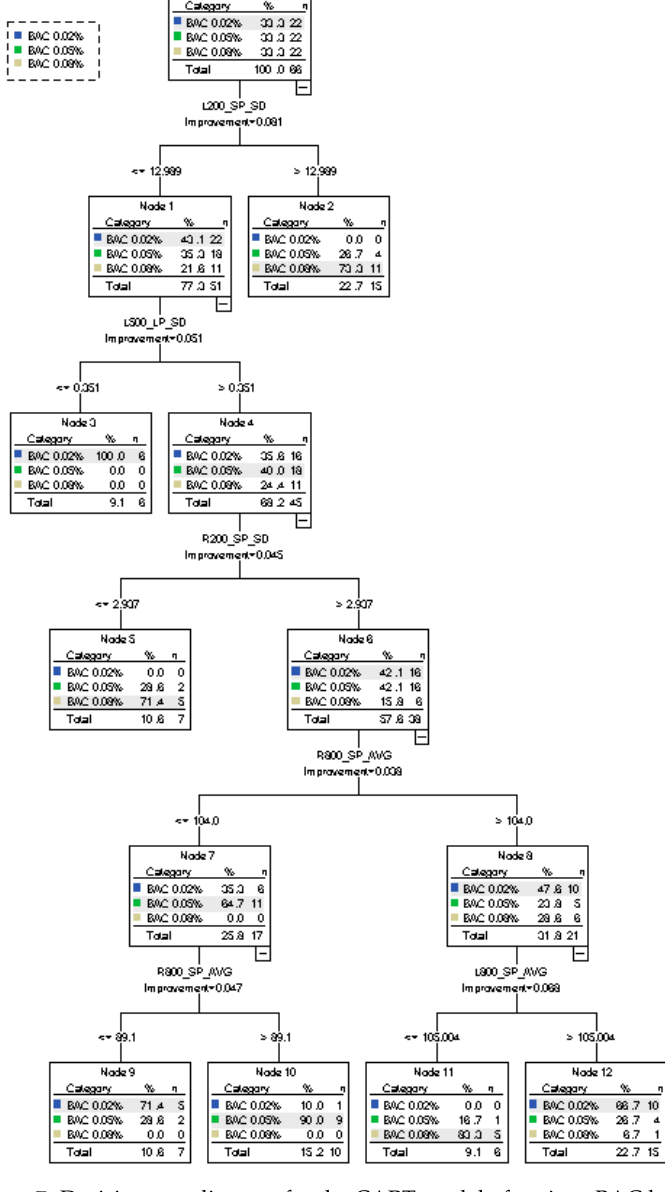
Figure 7. Decision tree diagram for the CART model of various BAC levels.